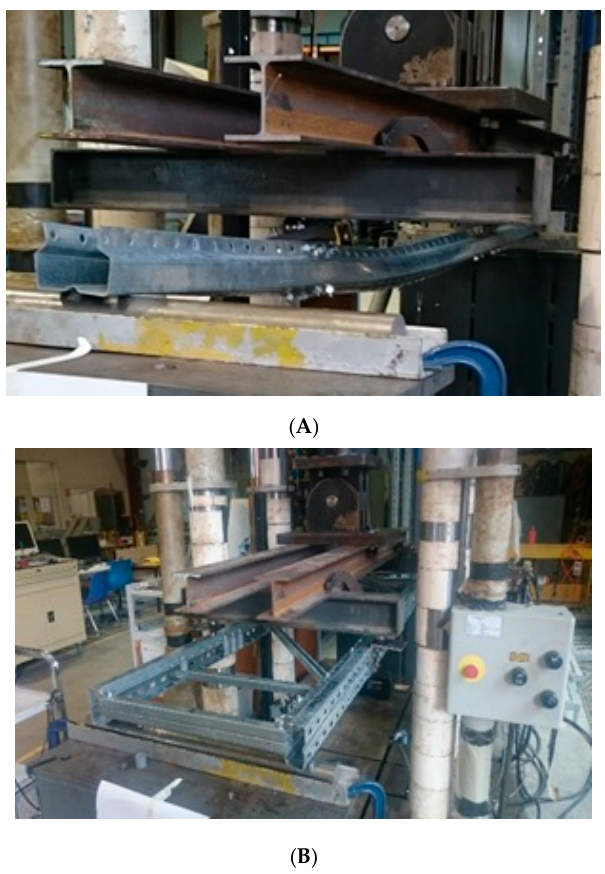
Figure 9. Test set-up: ( A ) minor axis test, ( B ) major axis test.